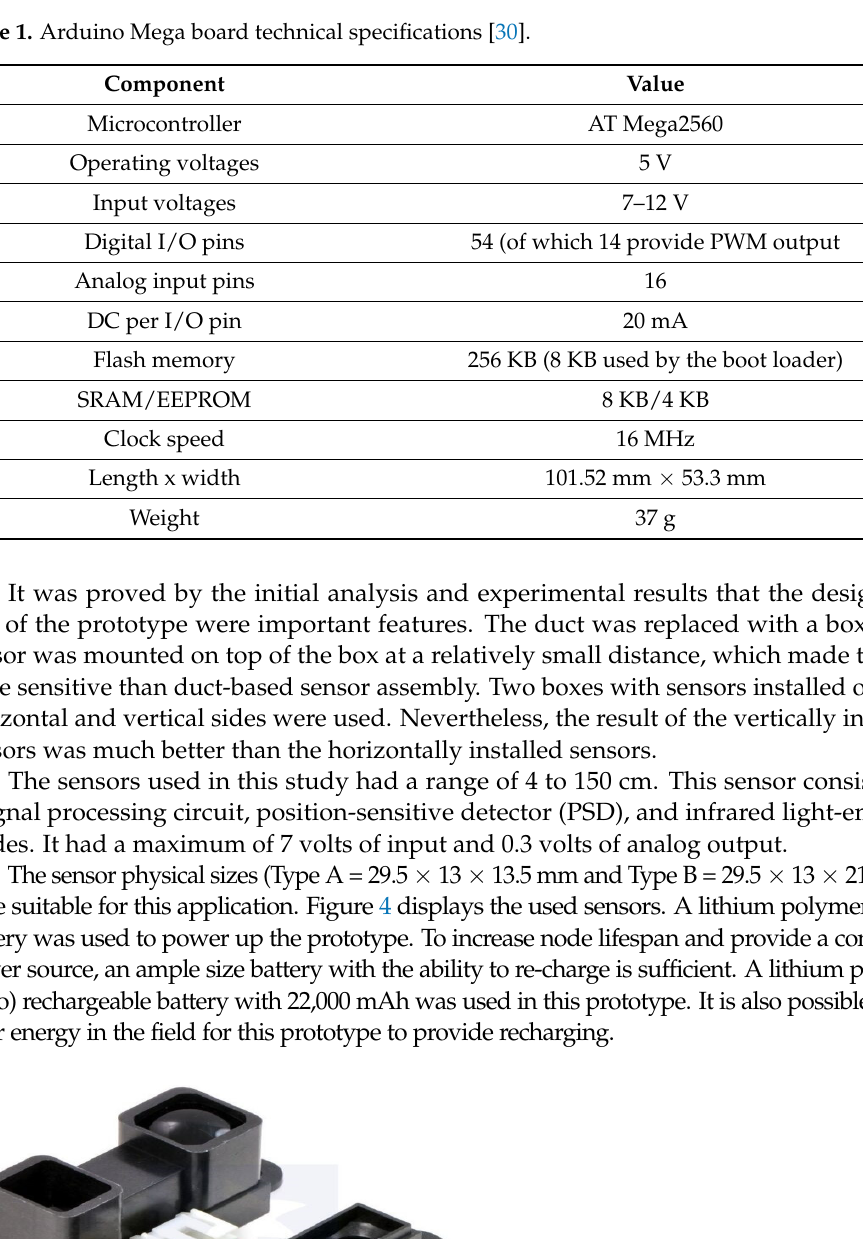
Table 2. Sensor manufacturer specifications [31]. Sensor